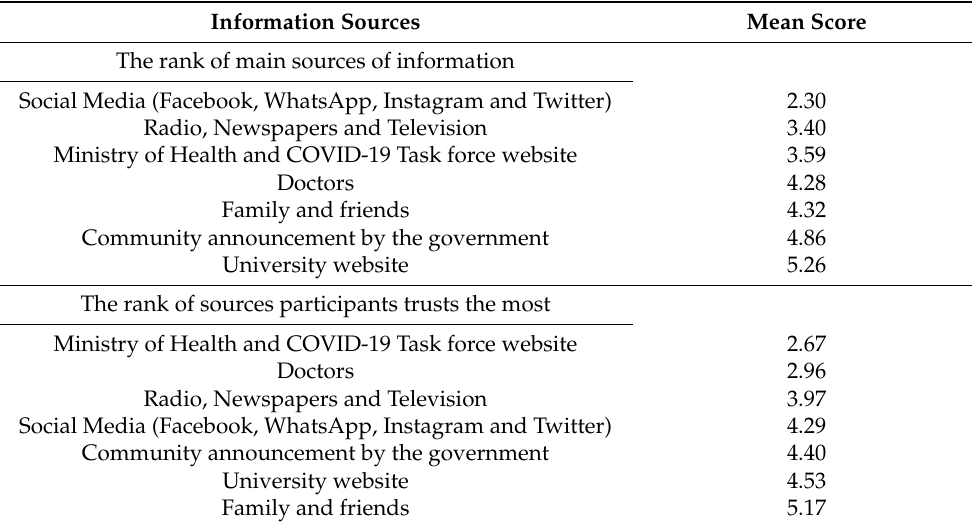
Table 6. Friedman’s test mean score on sources and trust in sources of information regarding COVID- 19 and the COVID-19 vaccine and vaccination.